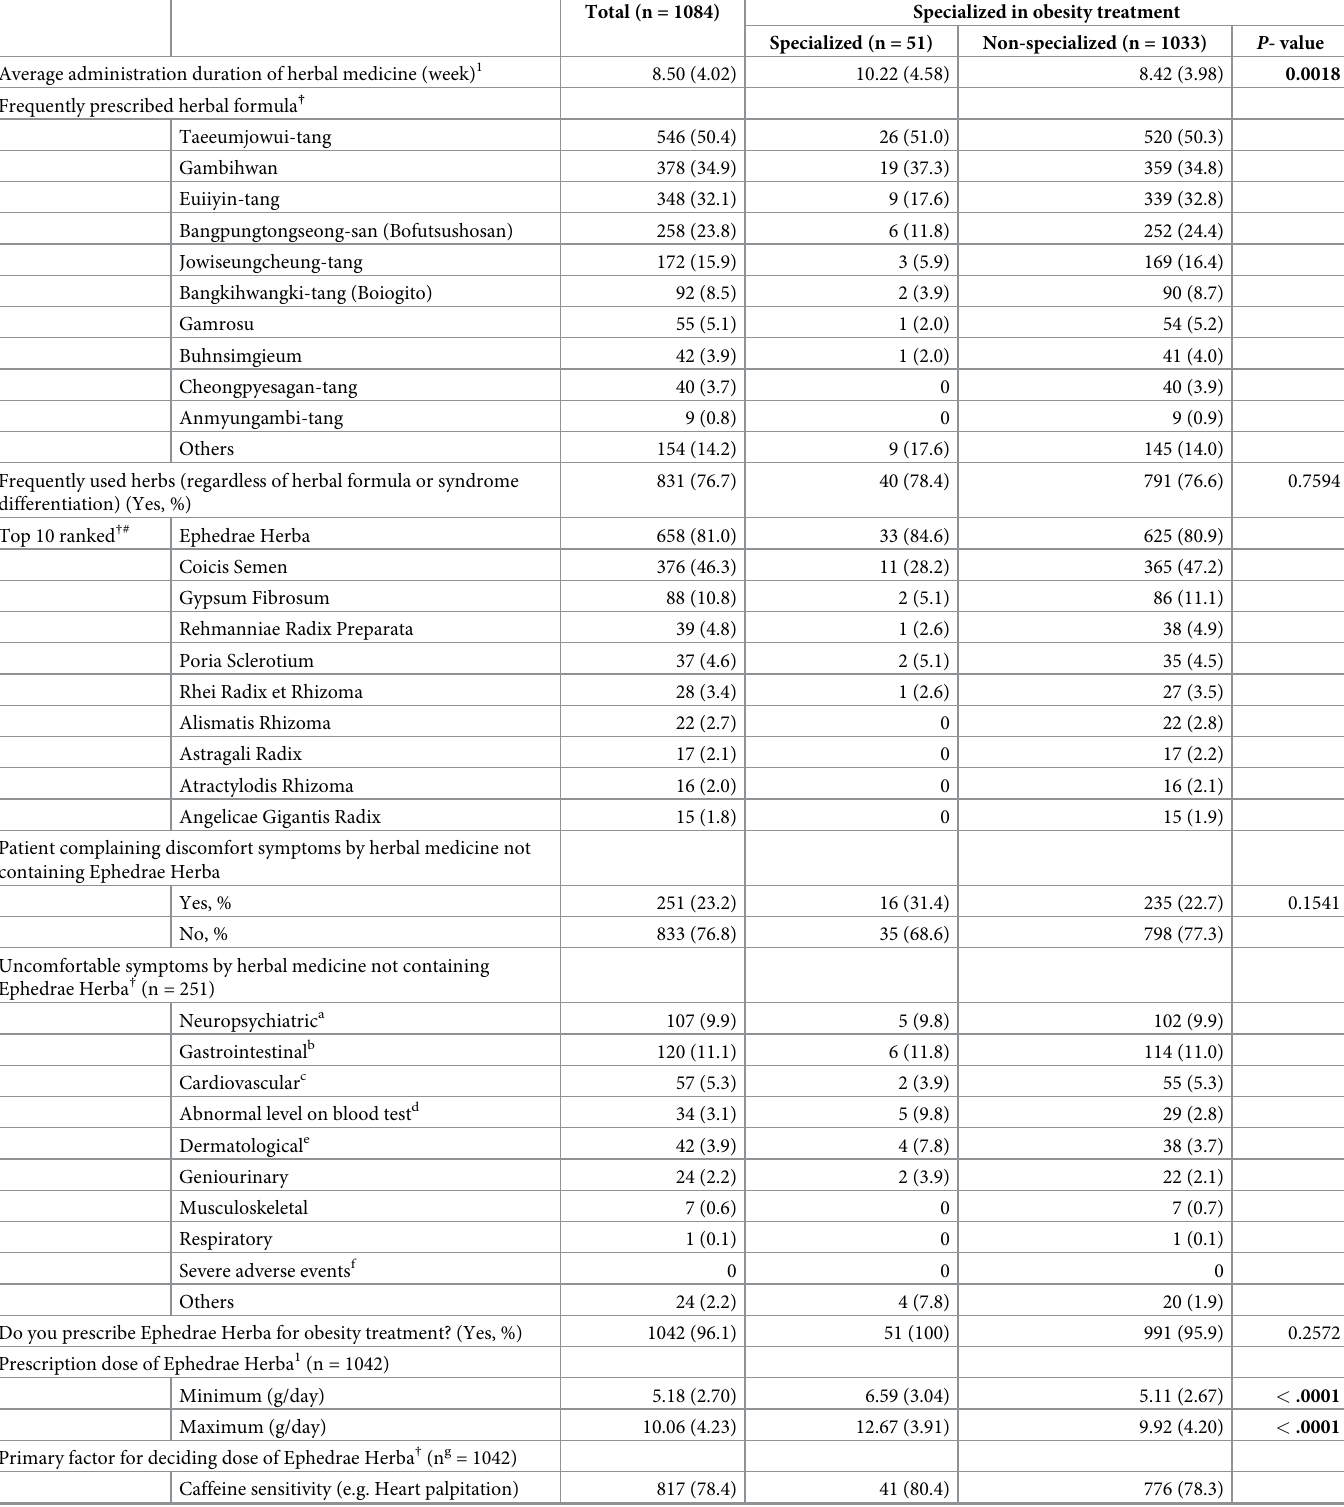
Table 4. Usage pattern of herbal medicine for obesity